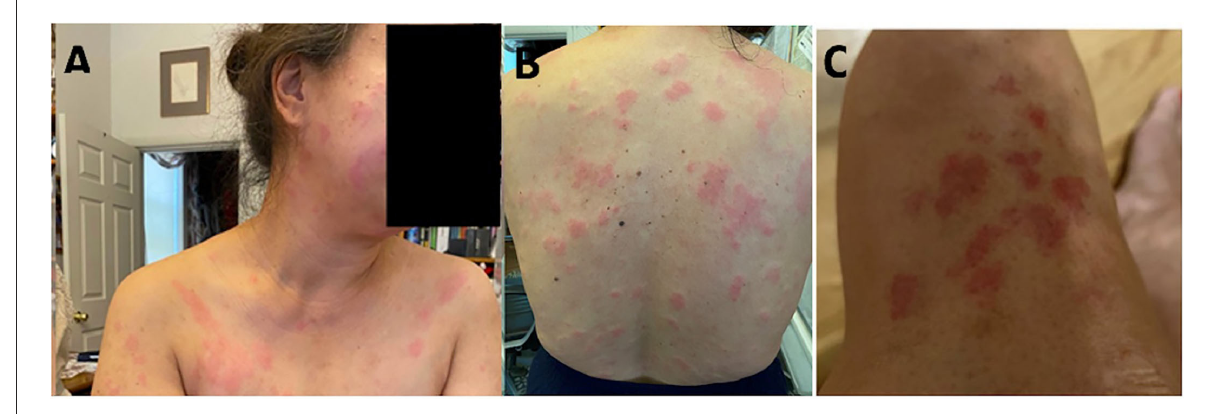
FIGURE1 Illustration of a patchy erythematous plaque-like rash on the face (A) and an erythematous plaque-like rash on the body (B,C)